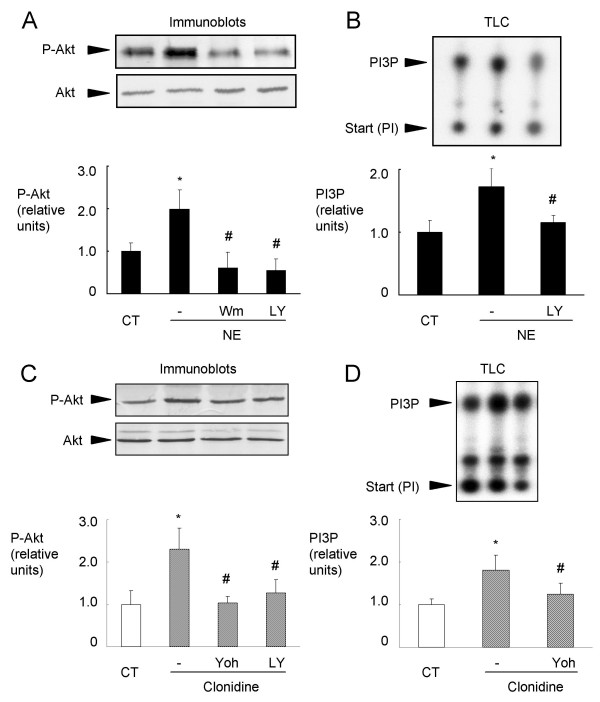
Exogenous NE and clonidine activate PI3Ks in canine isolated mesenteric vein. Immunoblots of Akt and phospho-Akt (P-Akt) in untreated control tissues (CT), and in tissues treated with NE (1 μM, 3 min) alone or after 60-min preincubation with 100 nM wortmannin, Wm, or 10 μM LY-294002, LY (A). Immune blots of P-Akt in veins incubated with clonidine (1 μM, 3 min) in the absence or after 60-min preincubation with 0.1 μM yohimbine, Yoh (C). The phospho-Akt (P-Akt) band densities were normalized to the respective Akt band densities, and the P-Akt/Akt ratios of treated tissues were presented relative to the ratios of non-treated tissue controls (bar graphs in A and C, n = 3). Thin-layer chromatography (TLC) separation of PI3P, obtained upon in vitro phosphorylation of PI by immunoprecipitated PI3Kγ. PI3Kγ activation was assessed in untreated (control) tissue (CT) and in tissues incubated for 3 min with 1 μM NE (B) or 1 μM clonidine (D), without or after 1-h preincubation with LY-294002 (LY, 10 μM) or yohimbine (Yoh, 0.1 μM). Phosphorylated PIP3 was quantified by radiography and densitometry, and PI3Kγ activation in treated tissues was expressed relative to non-treated tissue controls (bar graph, n = 3). *, P < 0.05 versus controls, #, P < 0.05 versus veins treated with NE or clonidine.